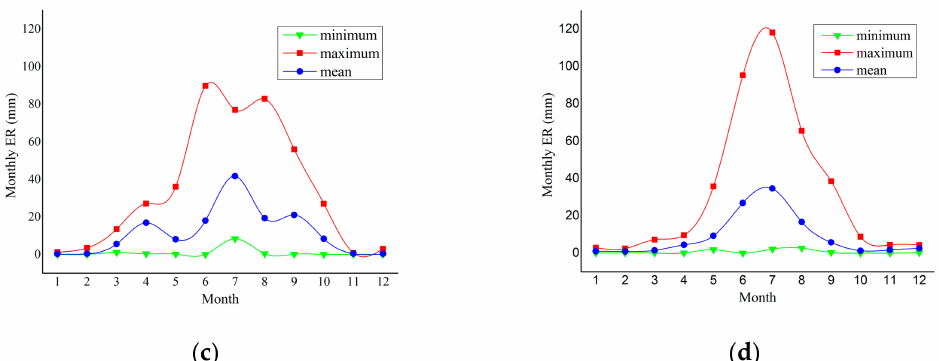
Figure 2. ER within the HRB in 2007 and 2012: ( a ) Spatial distribution of ER in 2007; ( b ) Spatial distribution of ER in 2012; ( c ) Monthly mean, maximum, and minimum ER in 2007; ( d ) Monthly mean, maximum, and minimum ER in